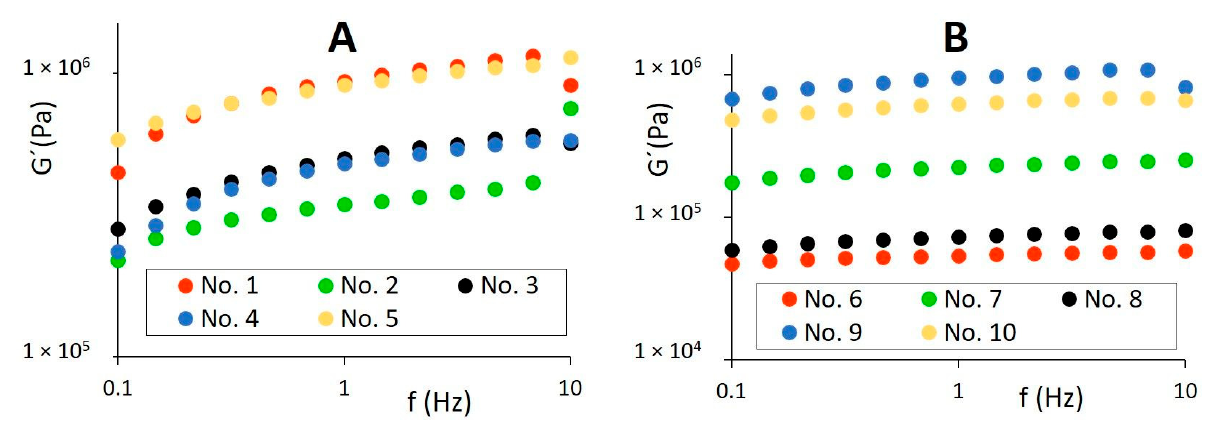
Figure 4. Elastic modulus (G ′ ) of butters ( A ), spreadable fats, and shortenings ( B ) dependent on frequency f in the region 0.1–10 Hz on logarithmic scale.